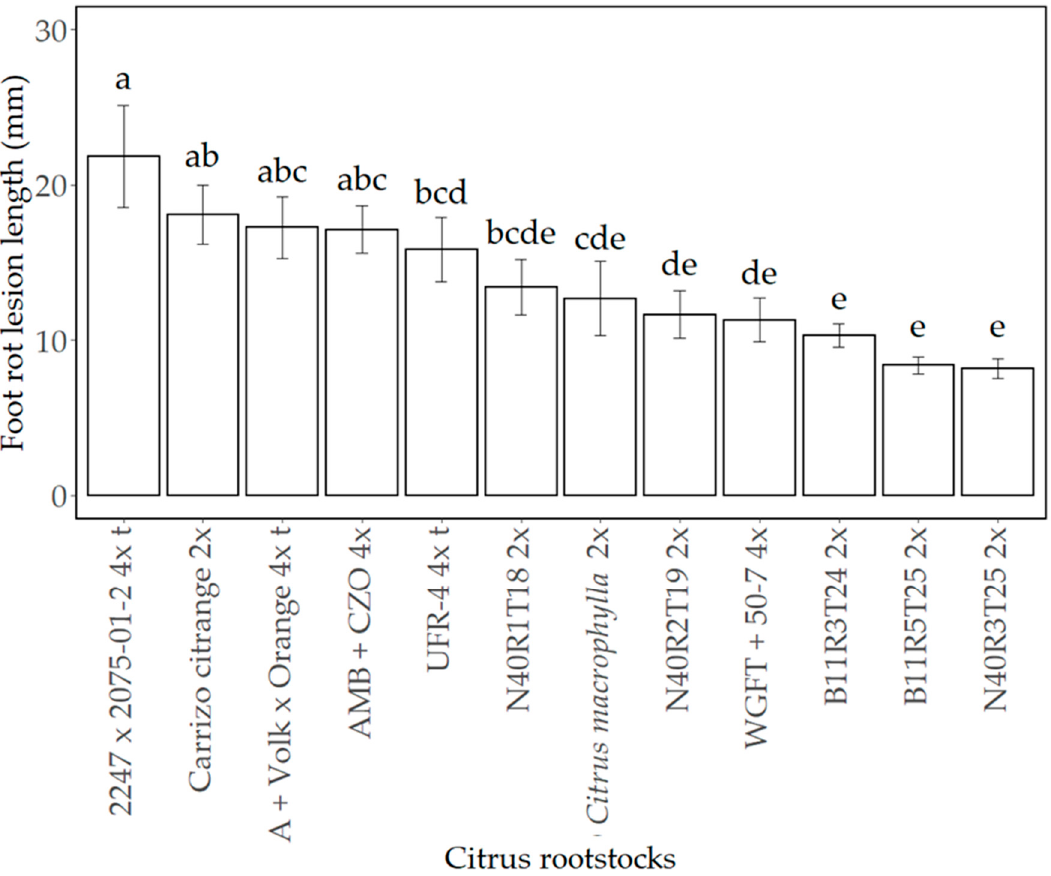
Figure 3. Mean foot rot lesion length response caused by P. nicotianae on twelve different citrus rootstocks tested during spring of 2020. Different letters above the bars indicate significant differences among the citrus rootstocks assayed ( p < 0.05). A + Volk x Orange: A + Volk x Orange19-11-8. Ploidy: 2x; 4x; 4x t: 4x tetrazyg.